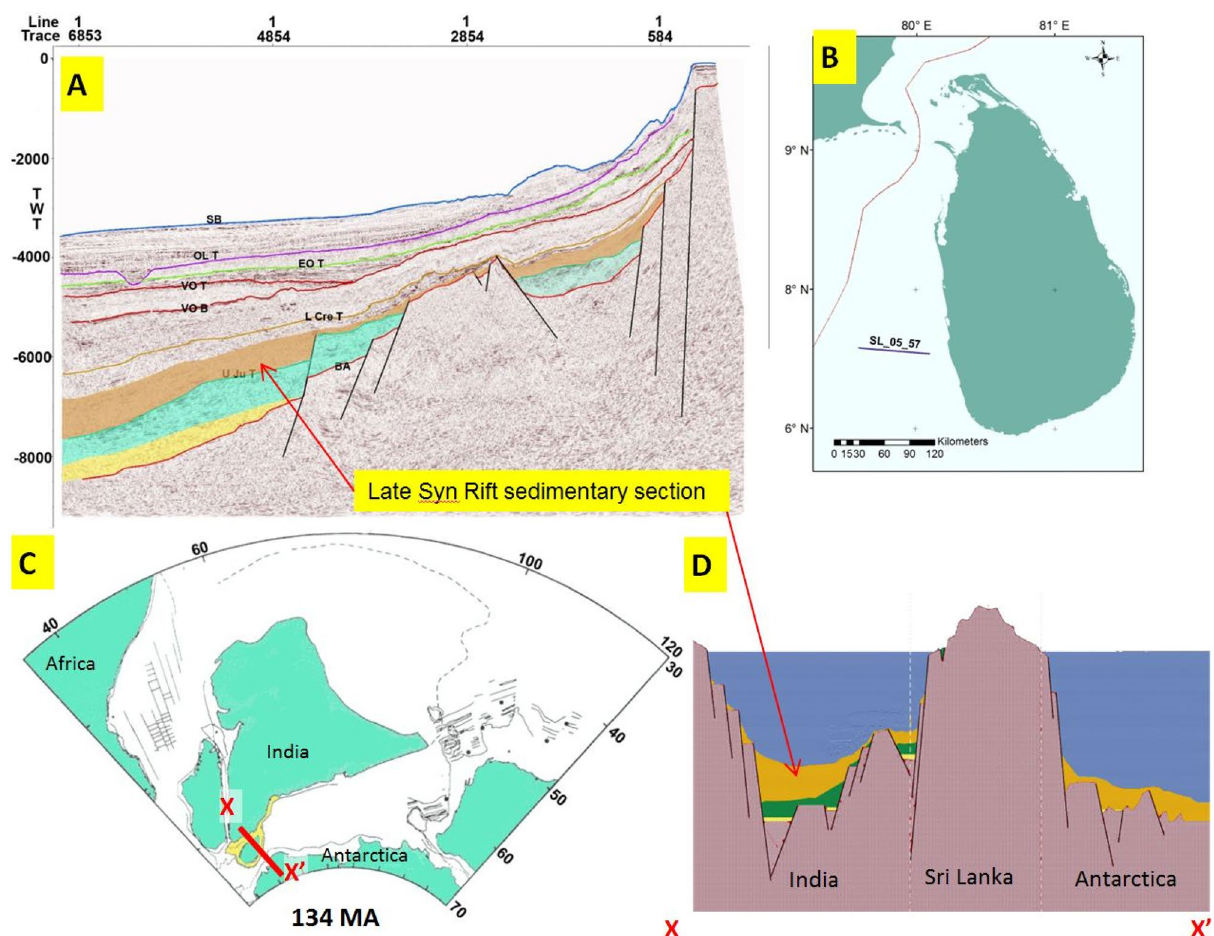
Fig. 7 a Seismic line SL-05-57 depicting the late syn-rift sediments above top Upper Jurassic (U Ju T) horizon. b A base map show- ing the location of line SL-05-57. c Plate tectonic reconstruction at 134 Ma representing the end of the late syn-rift phase and the con- figuration of east Gondwanaland (i.e. further widening of the Man- nar Basin, opening the Cauvery Basin and opening the Lanka